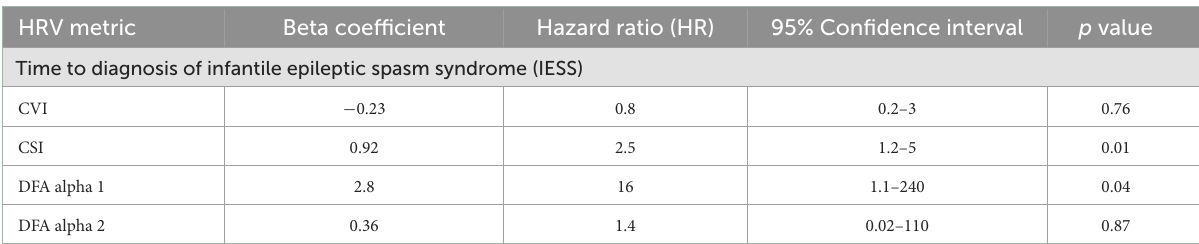
TABLE 3 Results of univariate cox-proportional regression